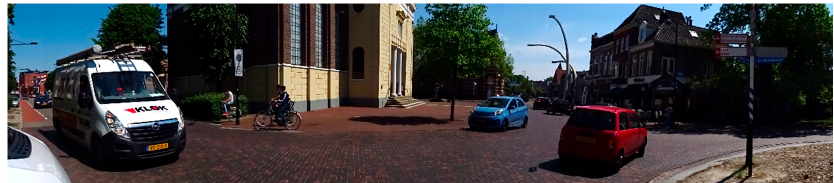
Figure 1. An impression of the city center of Assen, The Netherlands, f.t.t.b. Rolderstraat, de Markt, de Brink, Kerkplein.